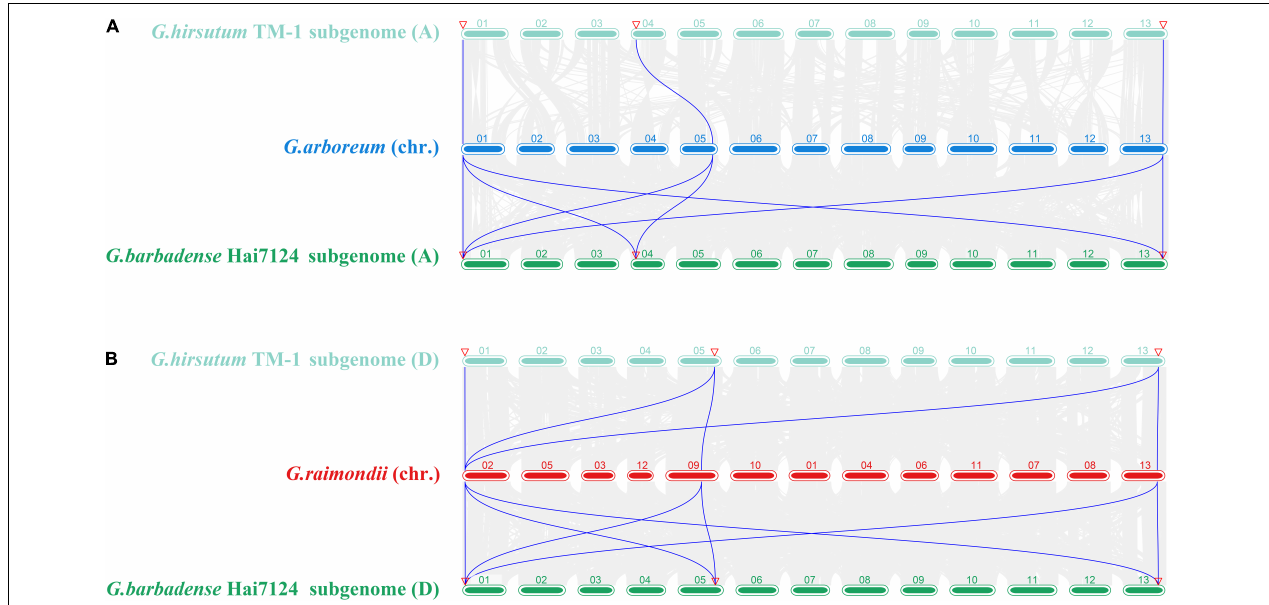
FIGURE 2 | Analysis of synteny among multiple Gossypium genomes about GW2 -like. (A) Synteny analysis among G. arboreum , G. hirsutum (At subgenome), and G. barbadense (At subgenome). (B) Synteny analysis among G. raimondii , G. hirsutum (Dt subgenome), and G. barbadense (Dt subgenome). TABLE 2 | Ka and Ks calculations for GW2- like duplicated gene pairs.